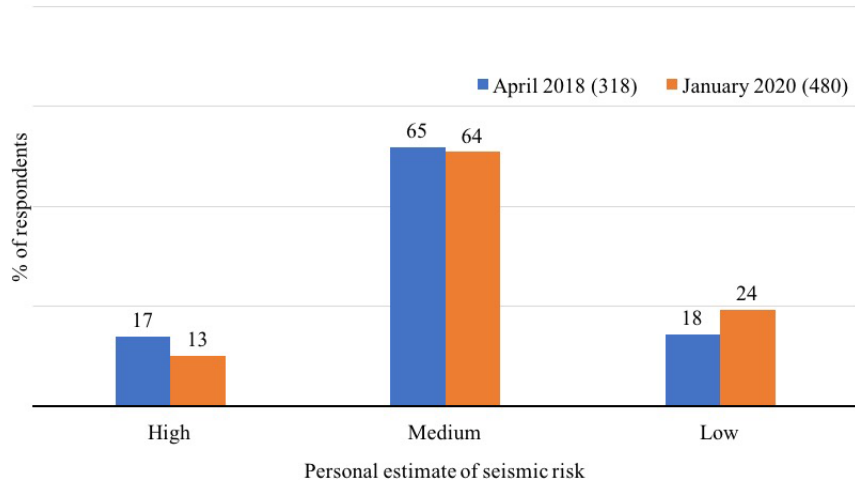
Figure 12. Students’ perception of the level of seismic risk in their respective location (Q10), before and after the initiation of our education program. ( χ 2 = 6 . 33 and p value = 0.042; the change is slightly above significant